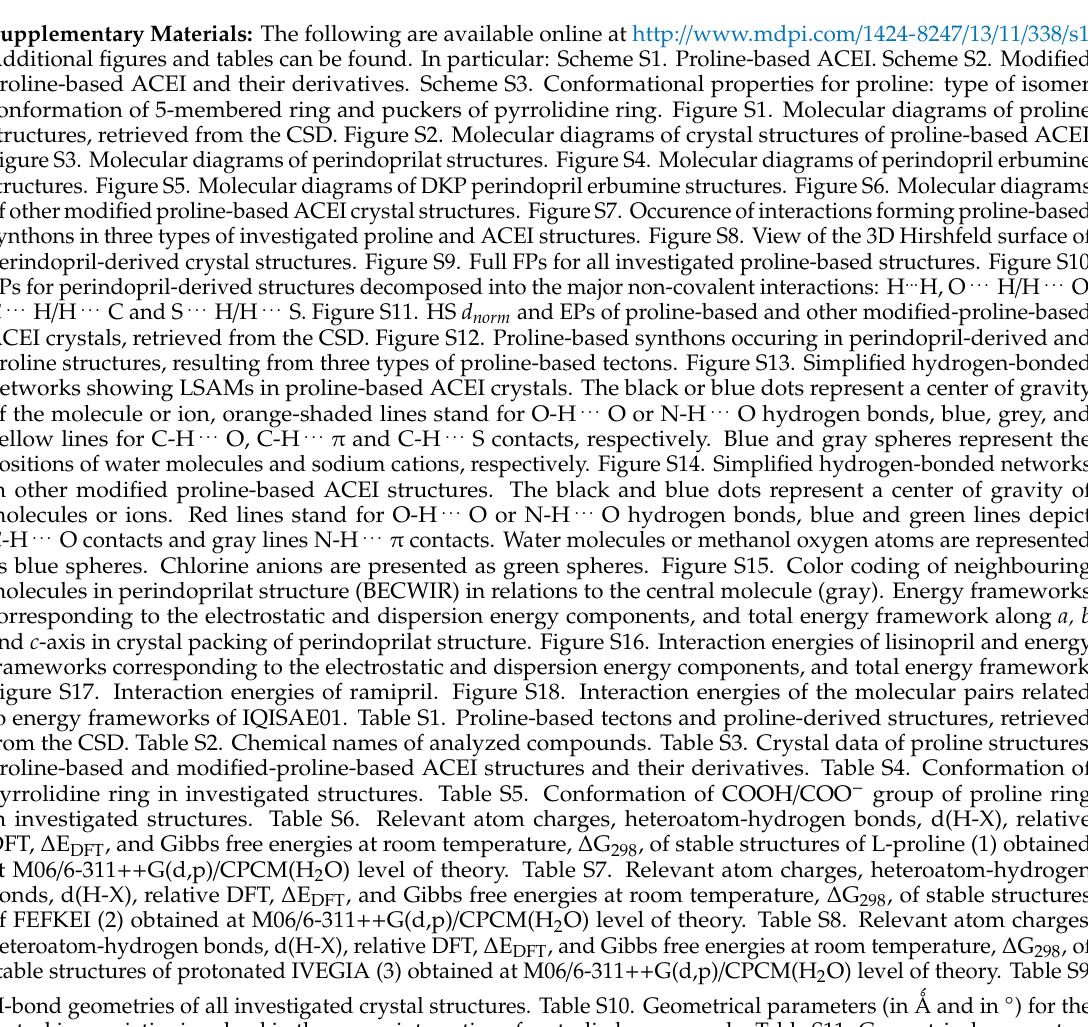
Table S19. Supramolecular synthon patterns formed by (NH 2 + ) in proline chain of investigated crystal structures. Table S20. Library of all supramolecular synthon patterns in all investigated crystals. Table S21. Names of Table S23. ADMET parameters of perindopril impurities. Table S24. ADMET parameters for proline-based ACEI compounds. Table S25. ADMET parameters for other modified proline-based ACEI compounds. Table S26. SwissADME parameters for proline-based and modified-proline-based ACEI